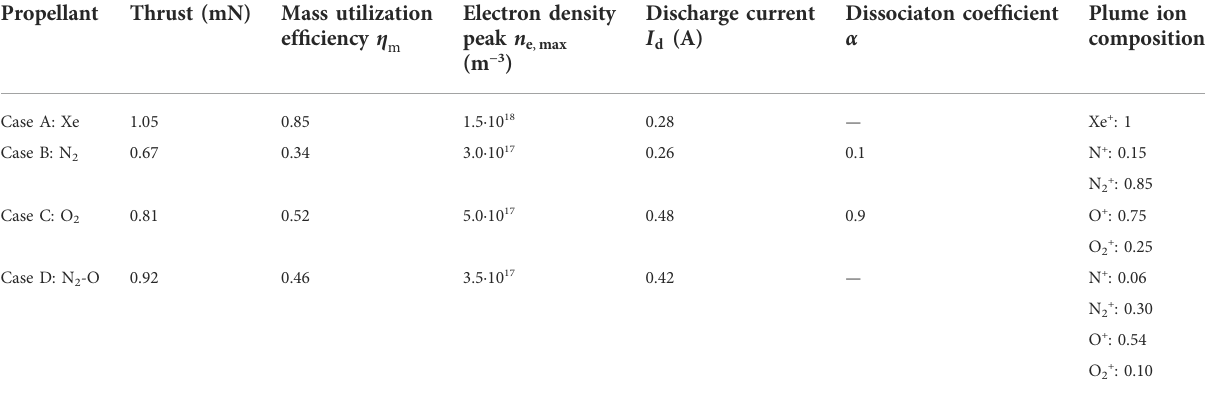
TABLE 6 Global performance and main plasma parameters corresponding to the different propellants.